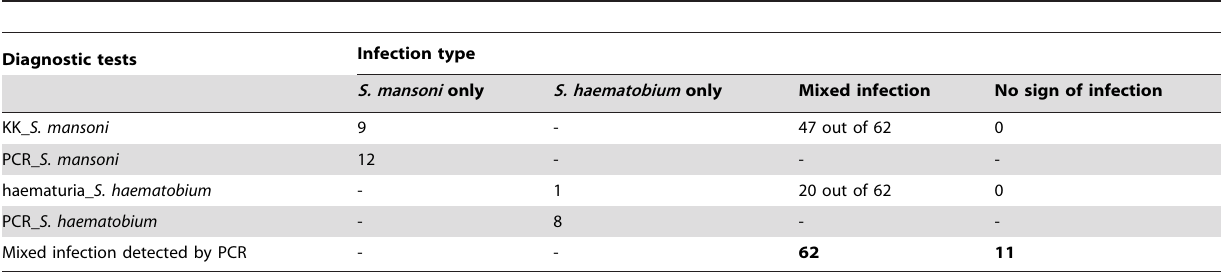
Table 5. Detailed numerical distribution of single and mixed schistosome parasite infected people from Ghana diagnosed by KK, haematuria and